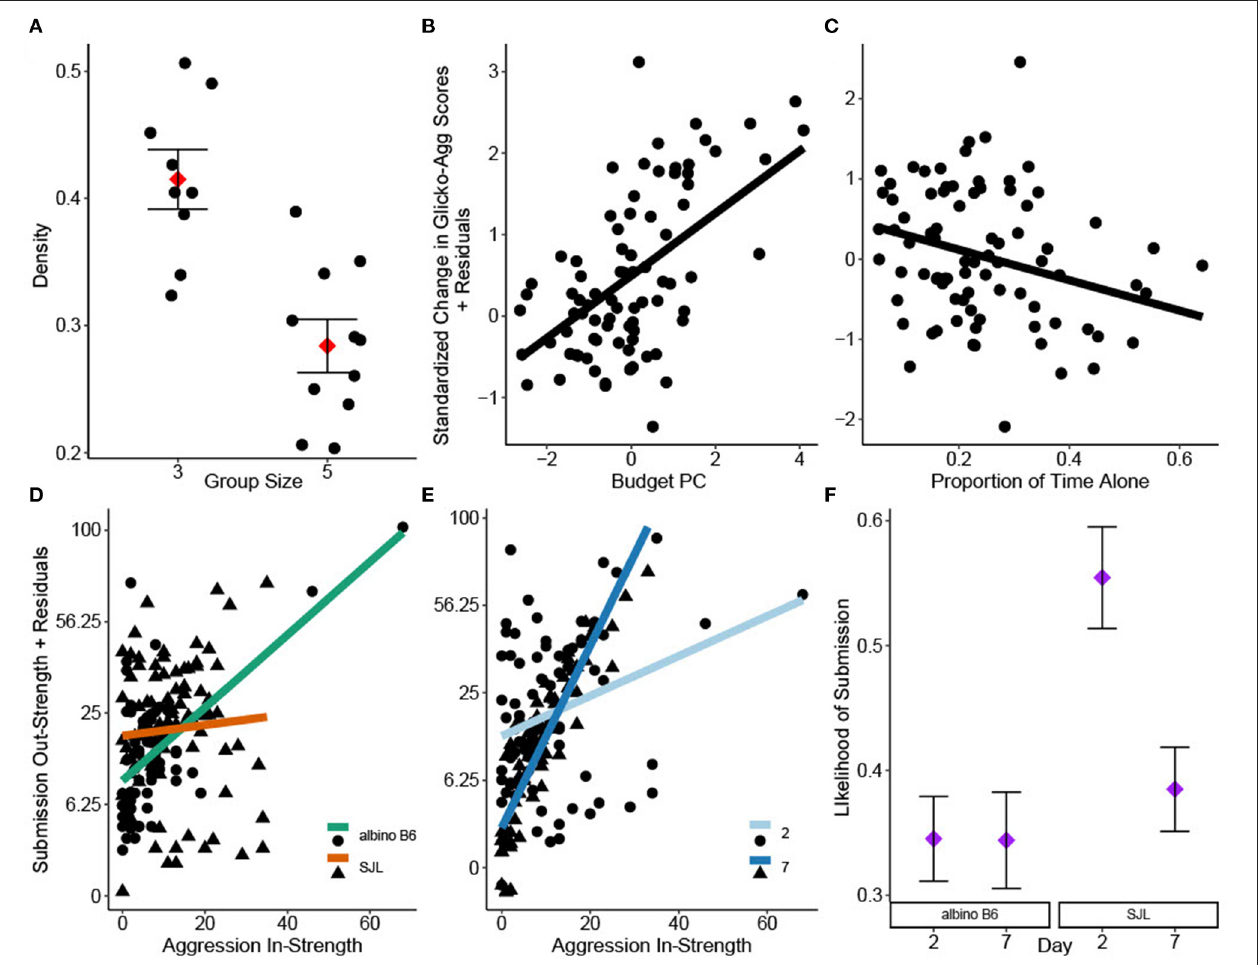
FIGURE 1 | Social network analyses of group housed albino B6 and SJL male mice. (A) Group size significantly impacted aggression density (adj. R 2 = 0.57, N = 20). Change in individual Glicko-Agg score was impacted by (B) Budget PC1 and (C) the proportion of time observed alone (adj. R 2 = 0.12, N = 82). Interactions of (D) strain*aggression in-strength and (E) day*aggression in-strength significantly influenced individual submission out-strength (adj. R 2 = 0.39, N = 156). Y axes in D and E are shown on a square root back transformed scale. (F) Binary logistic regression revealed a significant strain*day interaction on the likelihood that social investigation is followed by submission ( N = 2192). Data in A and F are presented as factor level LSM ± SE. Data in A are presented over the scatter of individual residual